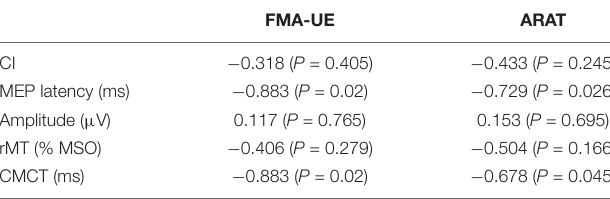
TABLE 3 | Correlation analyses between the motor function measures of affected limb, CI, and the MEP parameters of affected hemisphere. FMA-UE